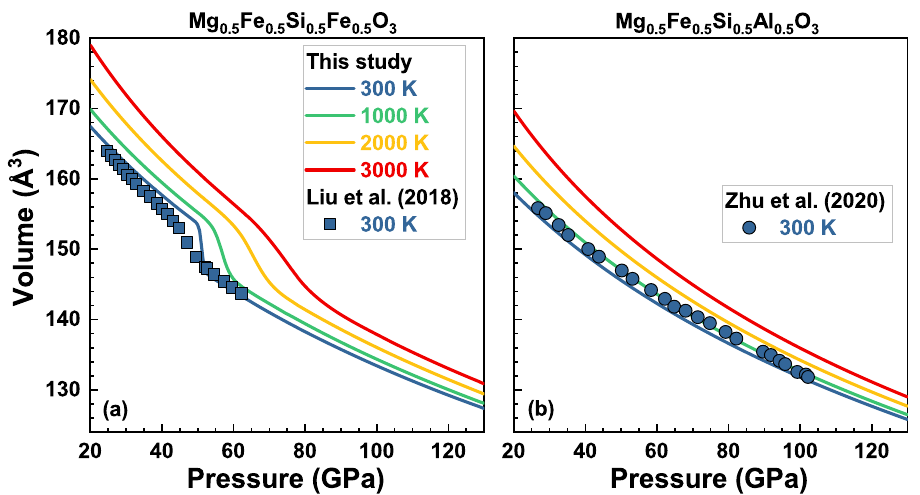
Fig. 2 Isothermal compression curves predicted by ab initio calculations for (Mg 0.5 Fe 0.5 )(Si 0.5 Fe 0.5 )O 3 and (Mg 0.5 Fe 0.5 )(Si 0.5 Al 0.5 )O 3 bridgmanite. a (Mg 0.5 Fe 0.5 )(Si 0.5 Fe 0.5 )O 3 bridgmanite, b (Mg 0.5 Fe 0.5 )(Si 0.5 Al 0.5 )O 3 bridgmanite. The blue, green, orange, and red curves are calculated compression curves of (Mg 0.5 Fe 0.5 )(Si 0.5 Fe 0.5 )O 3 and (Mg 0.5 Fe 0.5 )(Si 0.5 Al 0.5 )O 3 bridgmanite at 300, 1000, 2000, and 3000 K, respectively. The blue squares are experimental measurements from Liu et al. 36 , which shows that the spin transition of Fe 3 + in the B-site of (Mg 0.5 Fe 0.5 )(Si 0.5 Fe 0.5 )O 3 bridgmanite occurs between 43 and 53 GPa at 300 K. The blue circles are experimental results of Zhu et al. 42